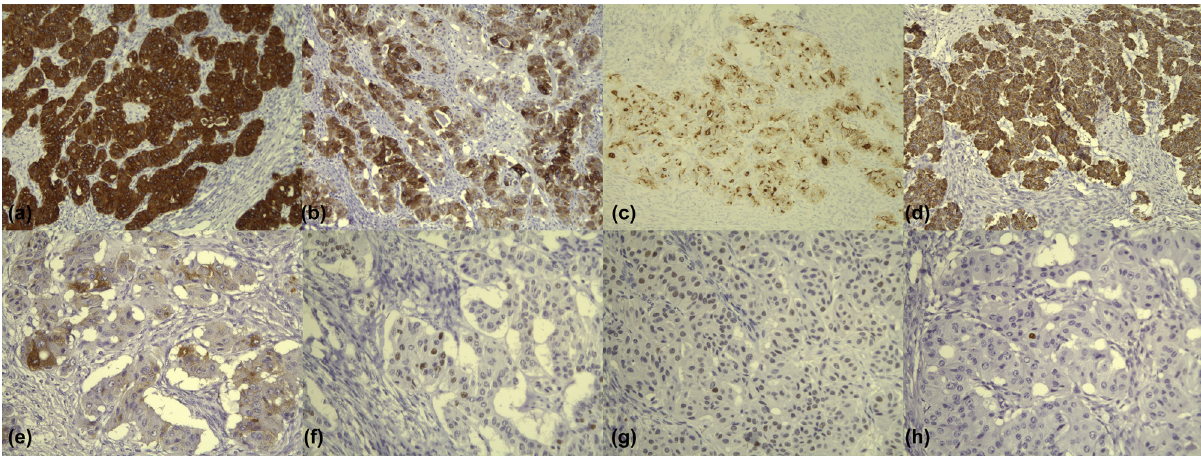
Figure 2: Immunohistochemical analysis of the tumor. ( a ) CK, × 10; ( b ) CK7, × 10; ( c ) CD10, × 10; ( d ) synaptophisin, × 10; ( e ) EMA, × 20; ( f ) estrogen, × 20; ( g ) progesterone, × 20; ( h ) Ki67, ×